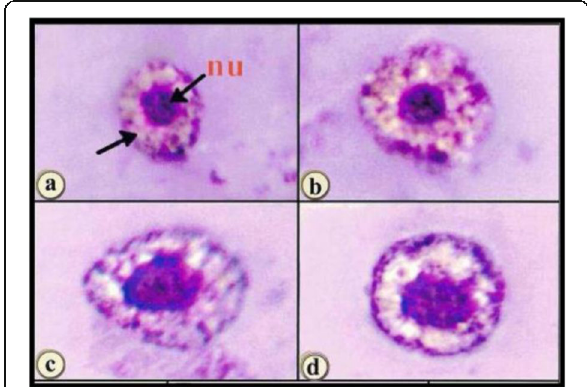
Fig. 7 Abnormalities in adipohemocytes ( x = 1600). a Normal: round containing variable amounts of refringent fat droplets (arrow). b 40 Gy and c 100 Gy; and d BA2 20 IJs/ml: increased the cell size than in control. nu indicates the hemocyte nucleus